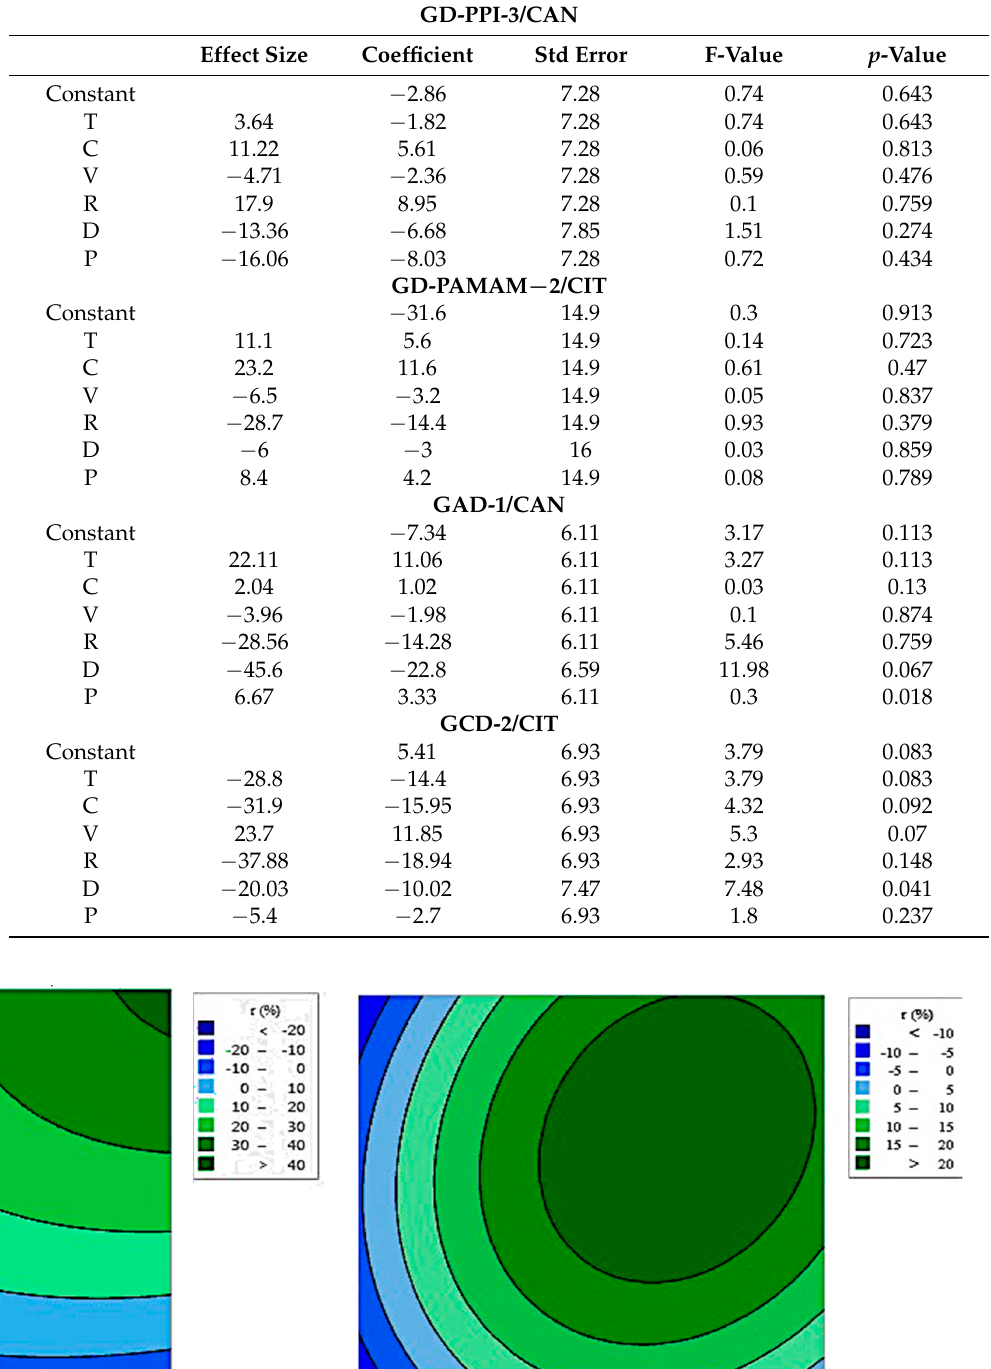
Table 6. Analyses of variance (ANOVA) of Plackett–Burman screening design experiments.